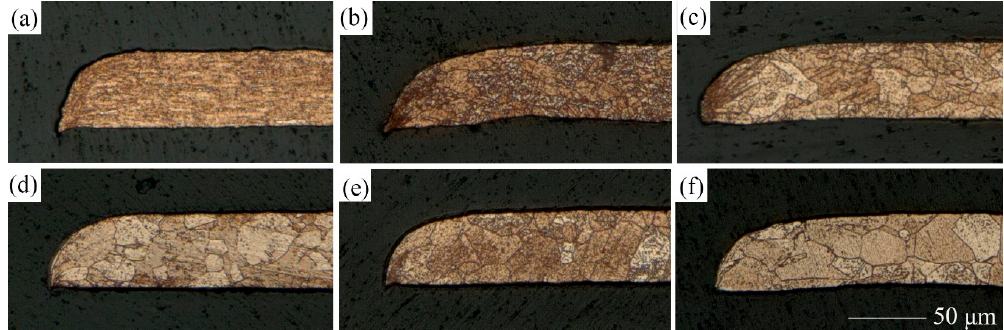
Figure 24. Microstructures of the punched parts with LPS under a laser energy density of 38.2 J/cm 2 . ( a ) Cold-rolled; ( b ) 350 °C annealed, 1 h; ( c ) 450 °C annealed, 1 h; ( d ) 550 °C annealed, 1 h; ( e ) 650 °C annealed, 1 h; ( d ) 650 °C annealed, 1 h.